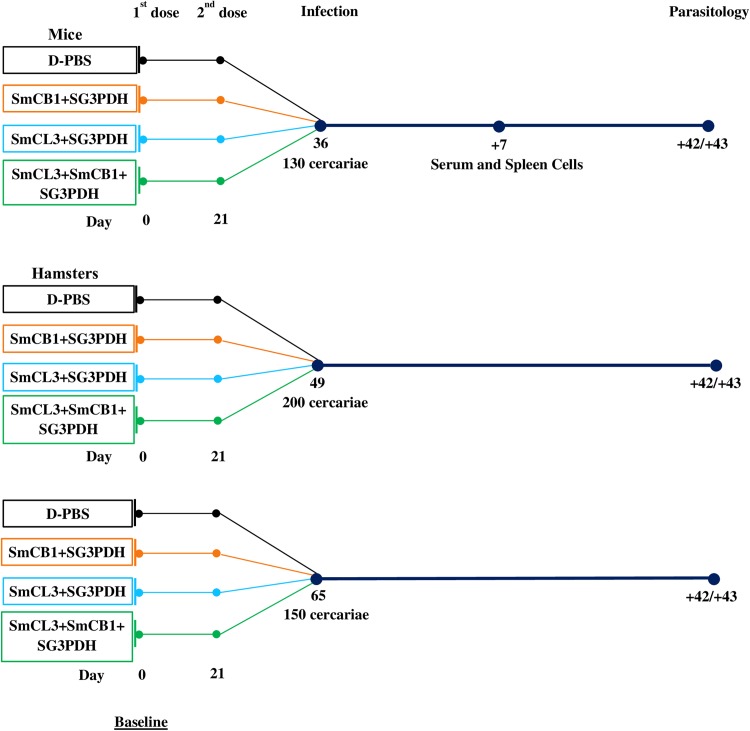
Overview of vaccine schedule using combination vaccine in mice and hamsters.Schedule show regime of vaccine delivery and challenge infection with schistosome cercariae. Time-points of tissue sampling and parasitological analysis are also shown.